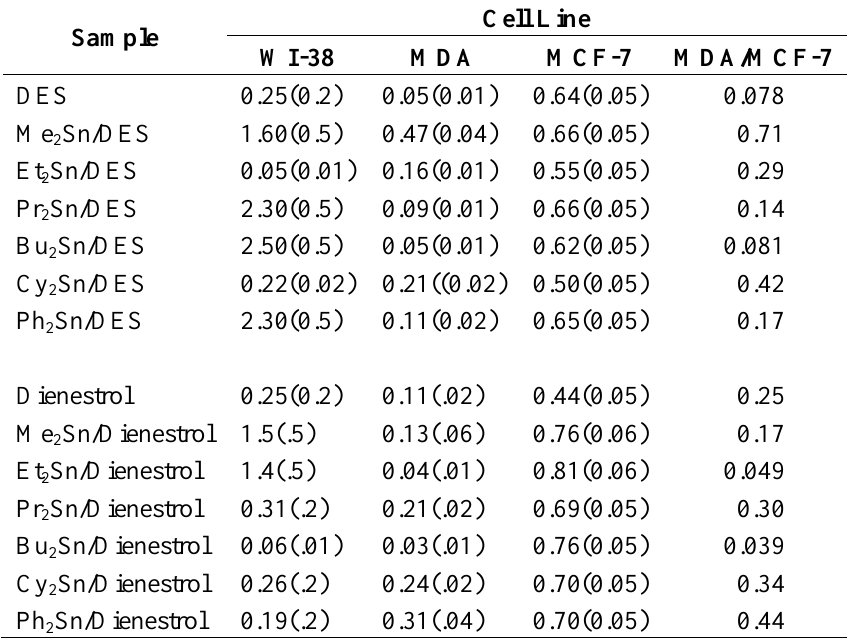
Table 5. GI concentrations (micrograms/mL) for organotin polyethers derived from 50 diethylstilbestrol (DES) and dienestrol for MDA and MCF-7 cell lines. Sample